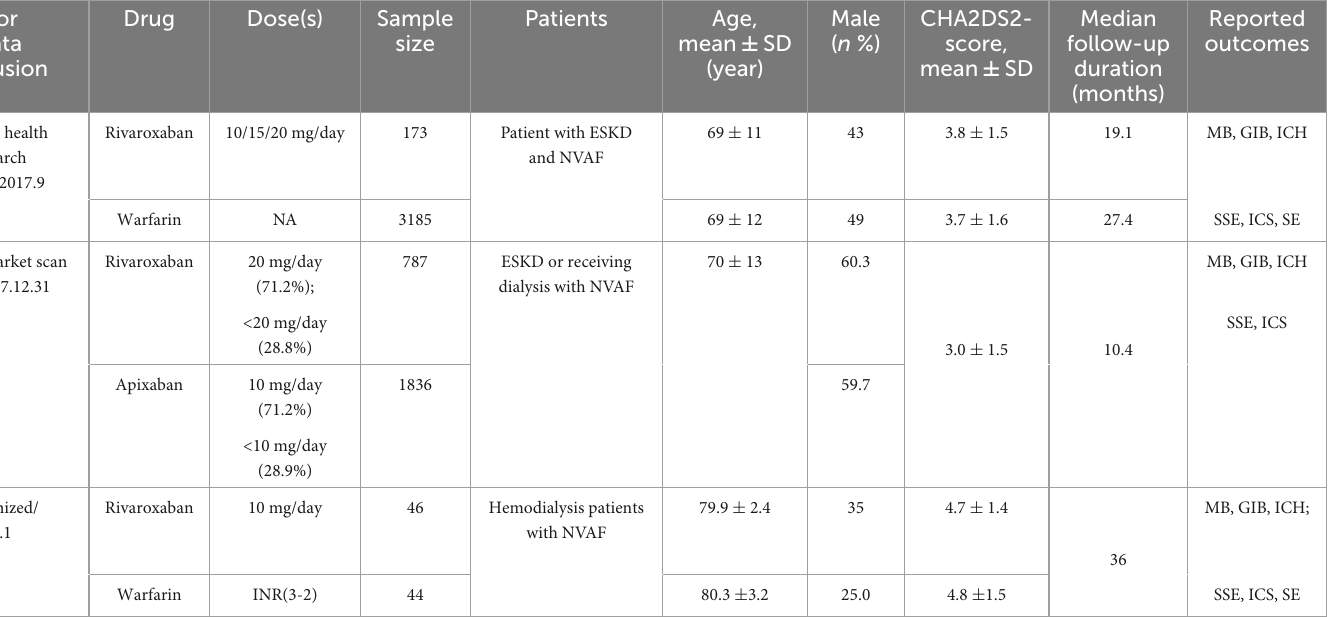
TABLE 1 Demographics and clinical characteristics of the included